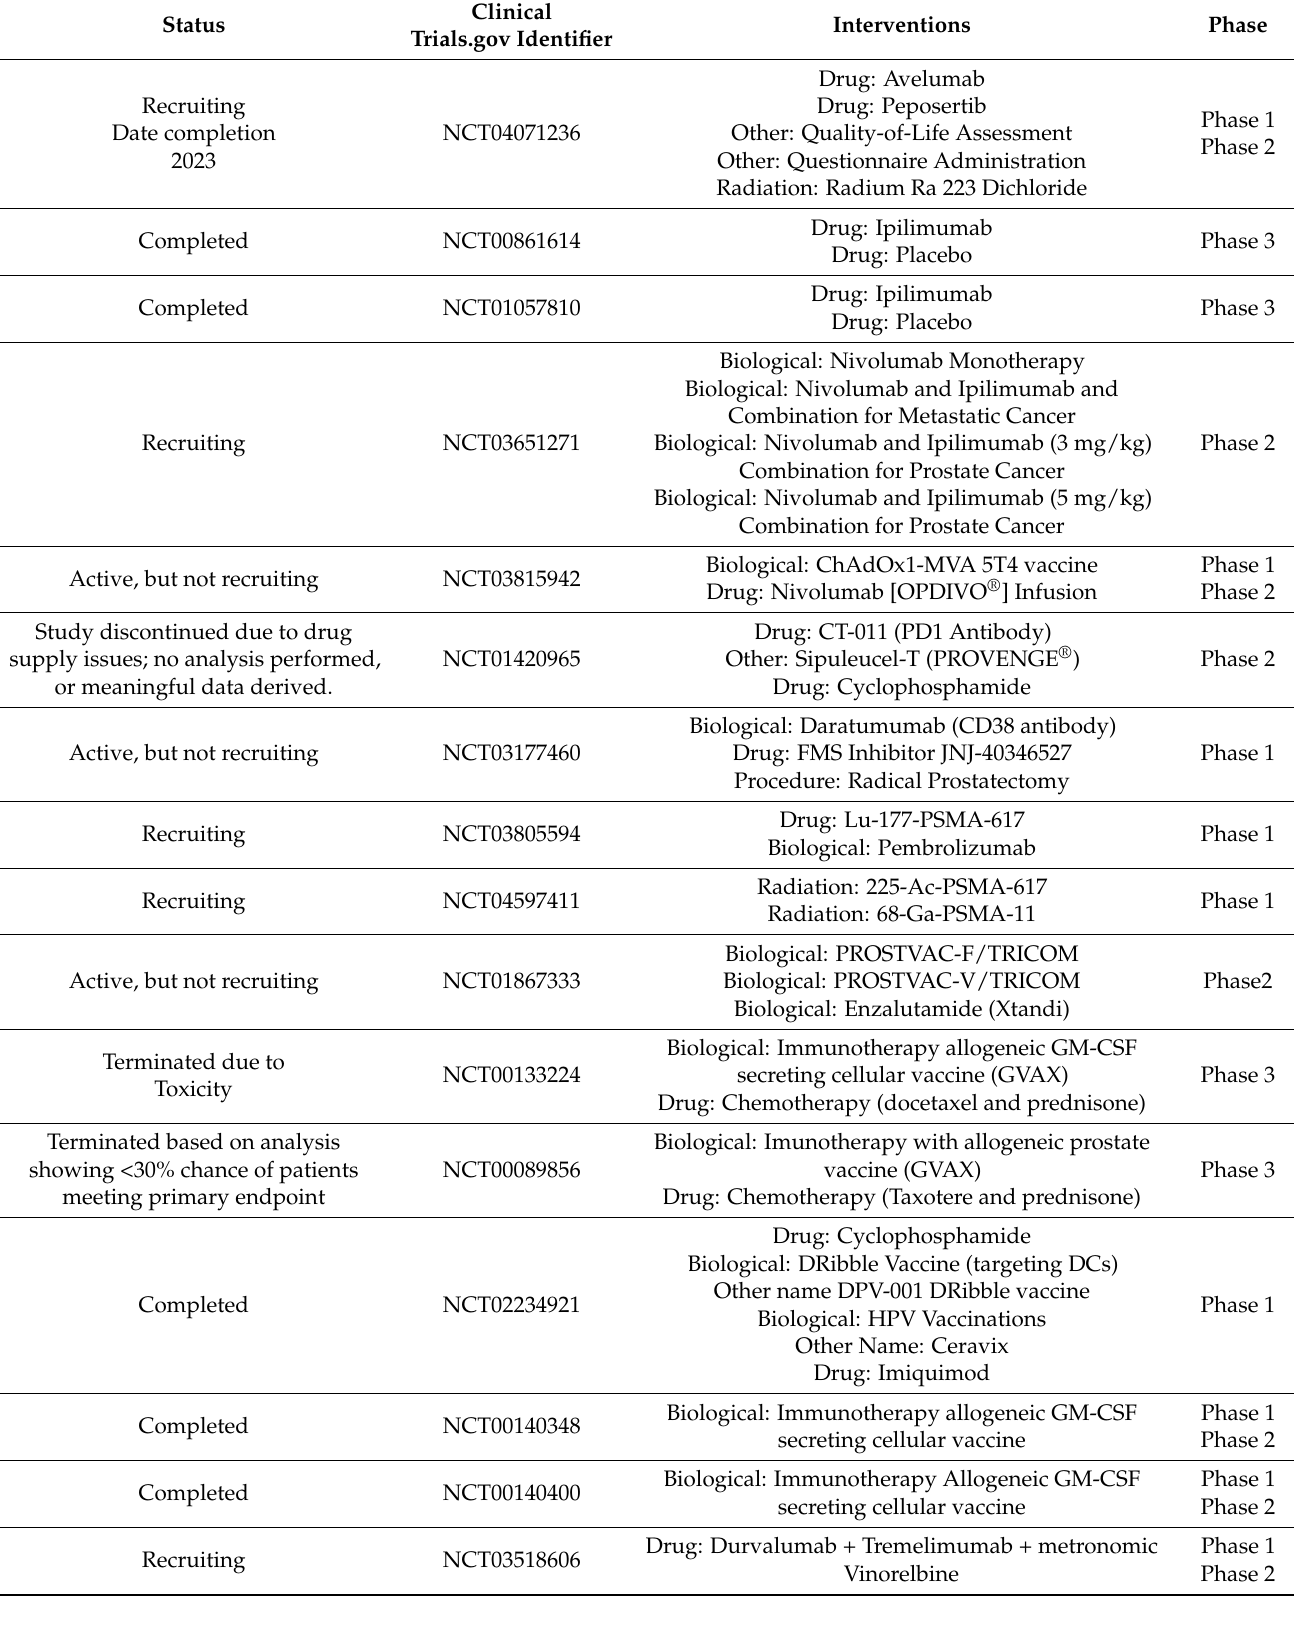
Table 1. Most recent clinical trials of PCa